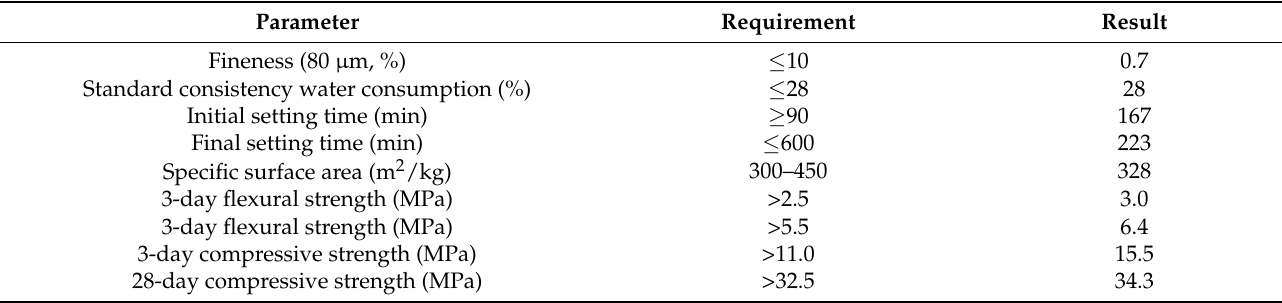
Table 4. Properties of the Portland cement used in the EAPM.